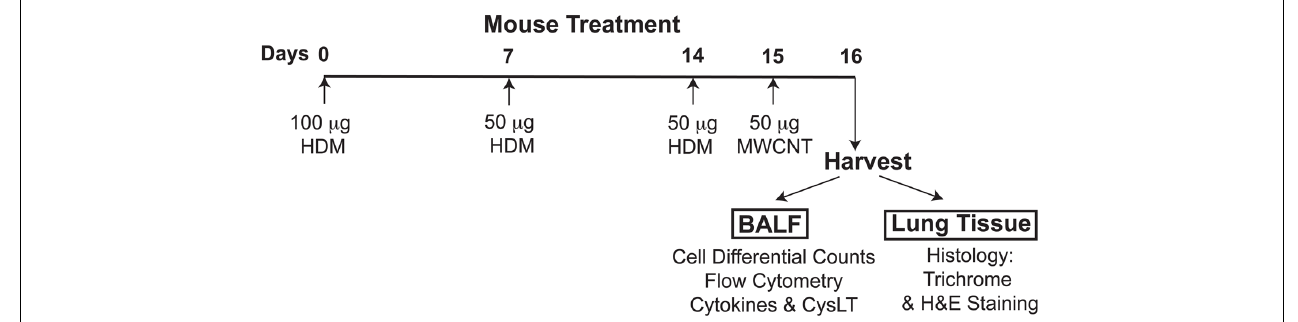
FIGURE 1 | The experimental design of the study, timeline of allergen challenges and intratracheal MWCNT administration. To elicit allergic lung inflammation, C57BL/6 mice (4–6 per group) were given a sensitization dose of HDM intranasally (100 µ g) on day 0, and then challenged with the allergen (50 µ g) on days 7 and 14. To examine the proinflammatory properties of MWCNT, HDM-sensitized mice were additionally exposed to a single 50 µ g dose of MWCNT by intratracheal instillation 24 h prior to harvest (on day 15). Control/sham-treated mice were given PBS and dispersion medium (in place of HDM or MWCNT, respectively). BALF and lung tissue were collected 24 h after MWCNT exposure (on day 16) for analysis of the lung inflammatory response.